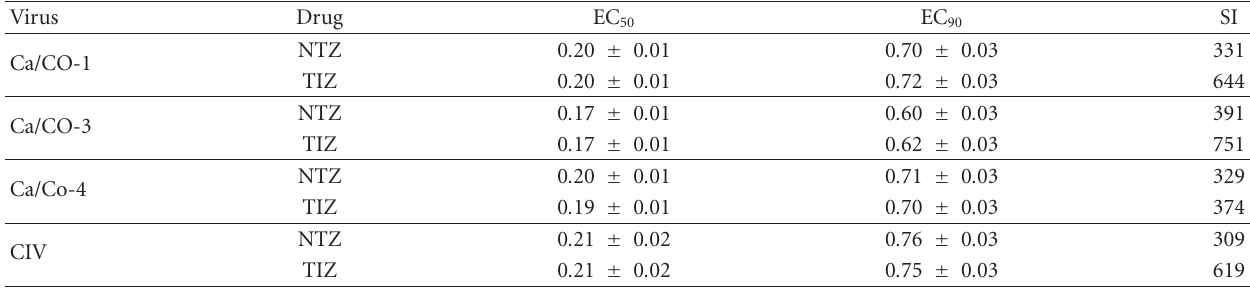
Table 1: In vitro activity of nitazoxanide (NTZ) and its active metabolite tizoxanide (TIZ) on clinical isolates of canine influenza virus (CIV).